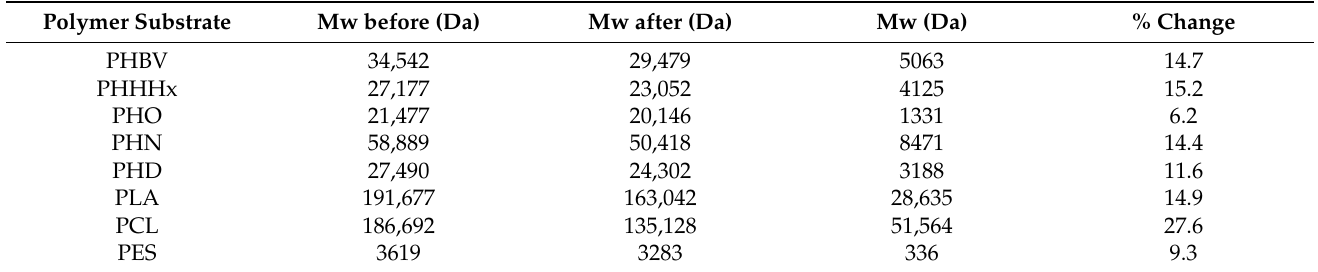
Table 6. Percent decrease in polymer molecular weight after treatment with